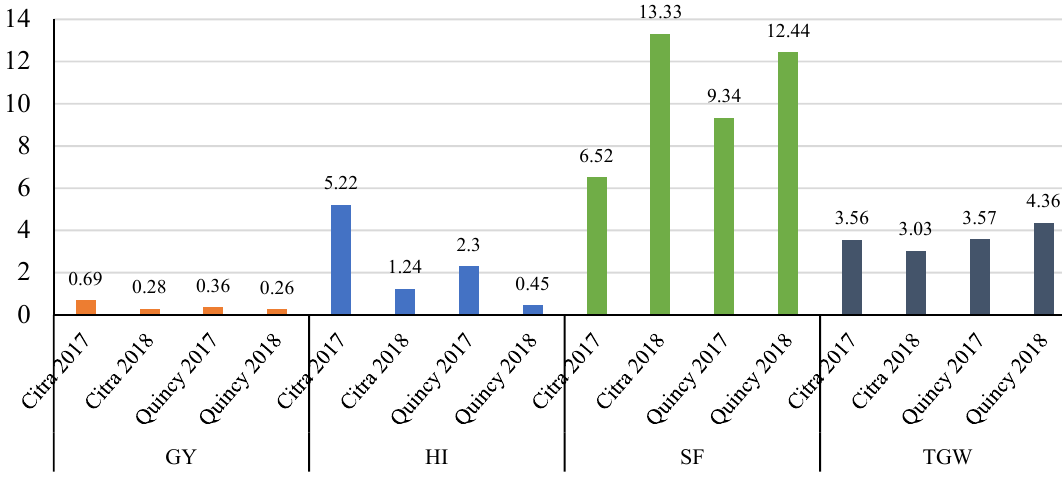
Figure 10. Response to selection for GY (ton ha − 1 ), HI (%), SF (grains/g chaff weight), and TGW (g) across environments using the BMOR model. GY, grain yield; HI, harvest index; SF, spike fertility; TGW, thousand grain weight. Mean response to selection for each environment were presented for each trait. The results of GY, HI, SF, and TGW trait were colored in orange, blue, light green, and blue ‐ gray.